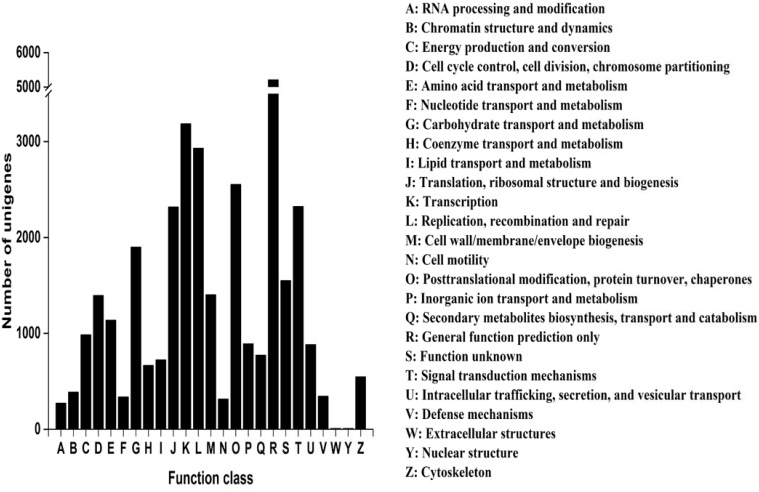
COG functional classification of Camellia sinensis transcriptome.In total, 31,159 unigenes with significant homologies in COG database (E-value ≤10−5) were classified into 25 COG categories. Capital letters on x-axis indicate COG categories as listed at right of histogram; y-axis indicates the number of unigenes.